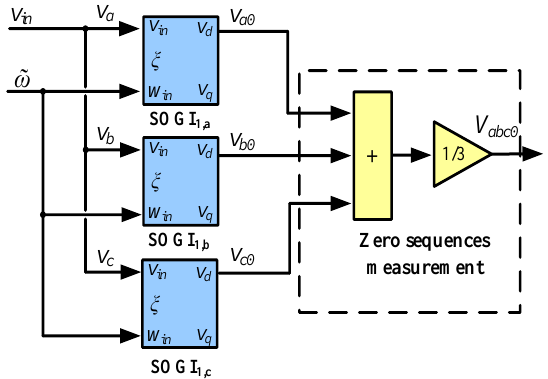
Figure 7. V abc 0 zero-sequence detection Figure 7. 𝑉 𝑎𝑏𝑐0 zero-sequence detection block-scheme. Figure 7. 𝑉 𝑎𝑏𝑐0 zero-sequence detection block-scheme.